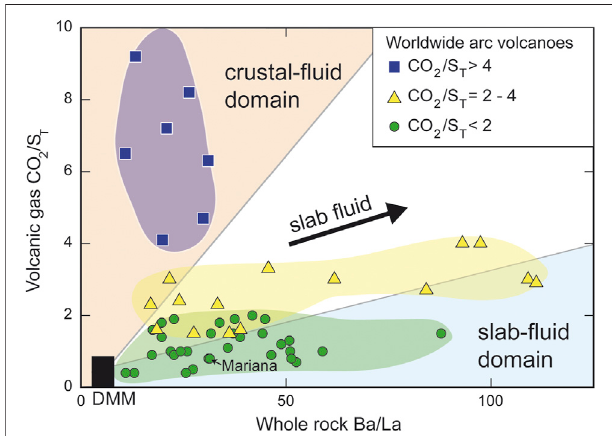
FIGURE 10 | Relationship between the CO 2 /S T outgassed in worldwide arc volcanoes and the slab- fl uid markers Ba/La of Aiuppa et al. (2017). Arc volcanoes were grouped according to their CO 2 /S T ratios, so that arc volcanoes outgassing large fl uxes of CO 2 have the highest CO 2 /S T (Aiuppa et al., 2017).Such arcvolcanoes aremostly continental arcs and they plot within the crustal fl uid domain (light red compositional fi eld), implying that the largest CO 2 fl uxes outgassed by volcanic arcs mostly come from crustal contamination, as emphasized by Lee et al. (2013). By contrast, island arc volcanoes that have experienced little crustal contamination, such as the Marianaarc,possesslowerCO 2 /S T ratiosthatplotwithintheslab fl uiddomain (lightblue fi eld). Thepositivecorrelationbetweenthe CO 2 /S T ratios outgassed in these island arcs (depicted as green circles and yellow triangles) and the slab- fl uidmarkers(Ba/La)demonstratesthattheCO 2 releasedinvolcanicarcs mainly derive from the subducted